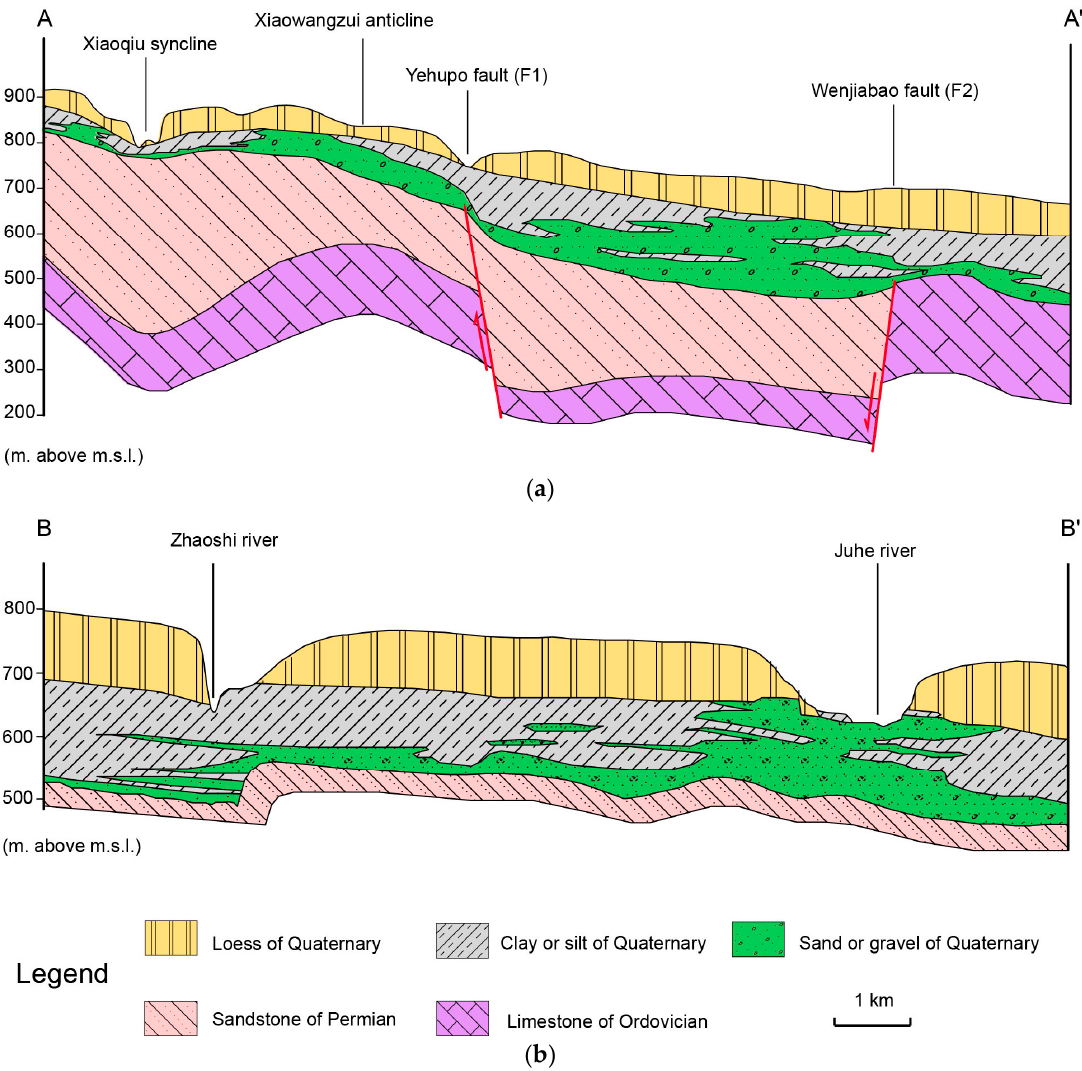
Figure 2. Lithological cross sections ( a ) A–A’ and ( b ) B–B’.